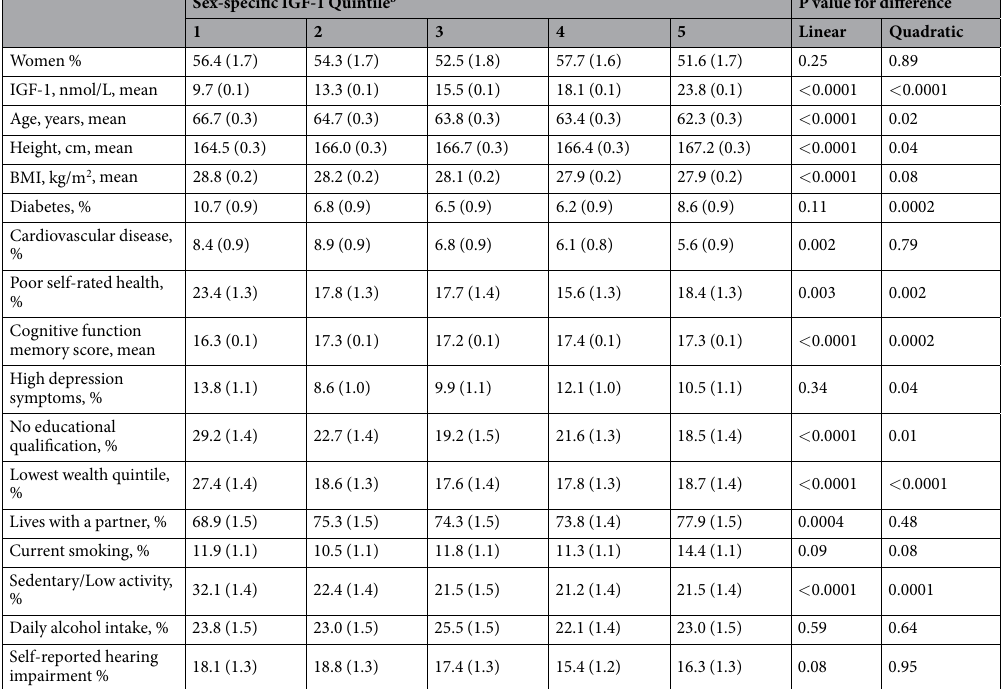
Table 1. Baseline characteristics a by sex-specific quintiles of serum Insulin-Like Growth Factor 1 (IGF-1) (2008 and/or 2012), the English Longitudinal Study of Ageing (n = 4390). Abbreviations: IGF-1, insulin-like growth factor 1; BMI, body mass index. a Values are means or percentages (standard error). b IGF-1 (nmol/L) range